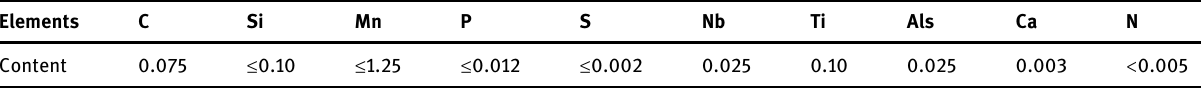
Table 1: Chemical composition of Nb – Ti composite microalloyed steels ( wt% )